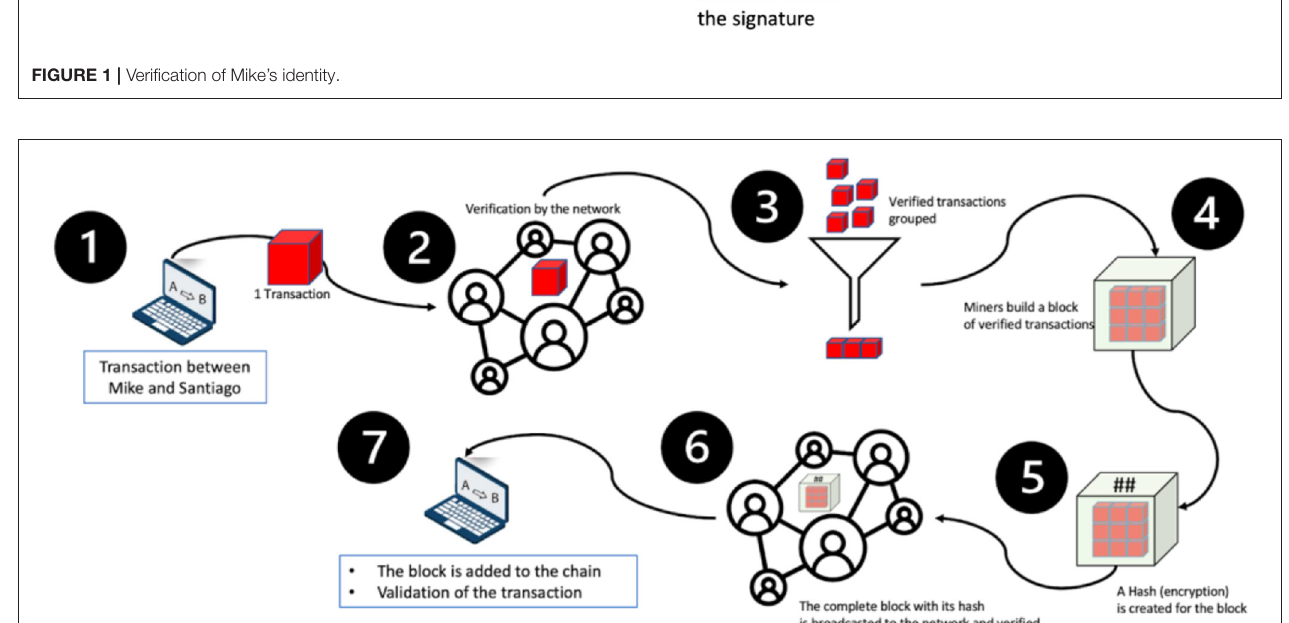
FIGURE 2 | Process of adding a transaction to the blockchain in 7 steps. The ## indicates the hash that was created for the block between steps 4 and